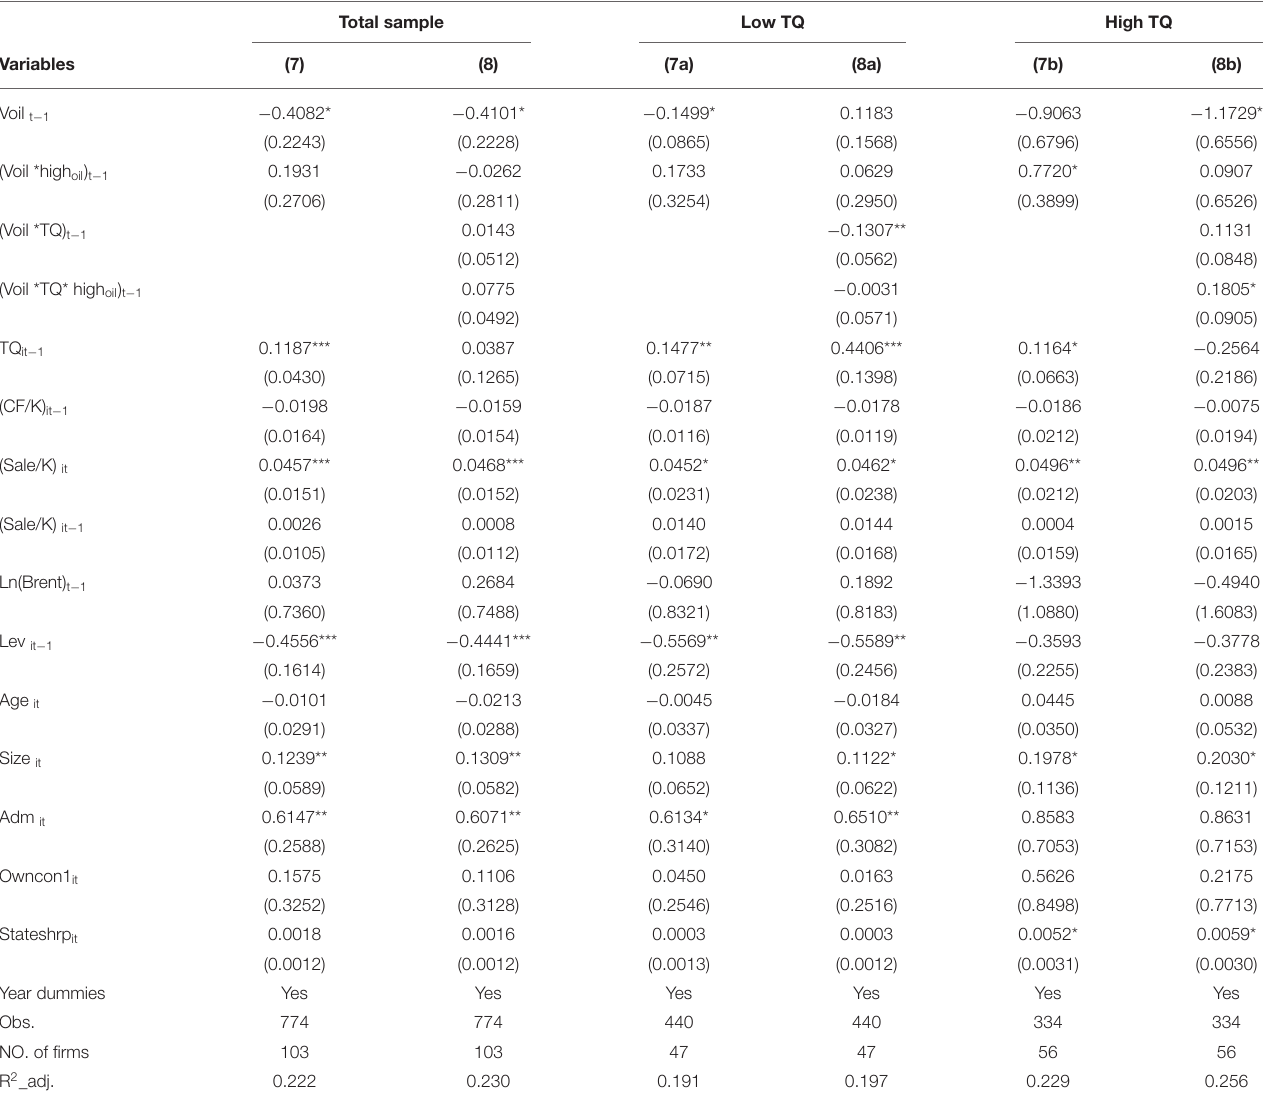
TABLE 4 | The asymmetric effect of oil price uncertainty on investment (High or low oil